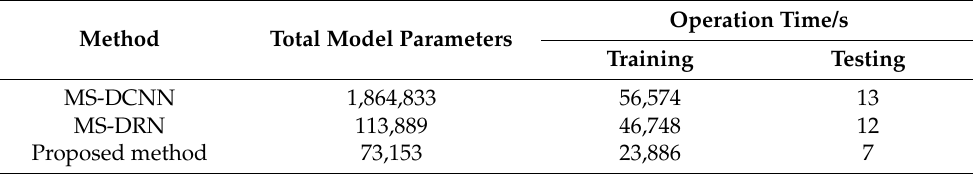
Table 4. Prediction performance comparison of the proposed method and the other two multi-scale CNN-based prognostics